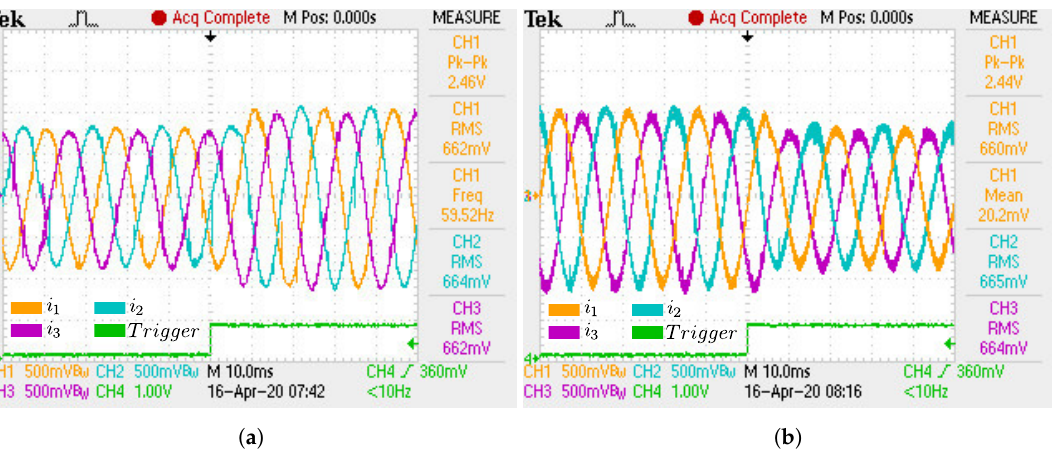
Figure 33. Experimental load phase currents for RL transition load case: ( a ) First transition; ( b ) Second